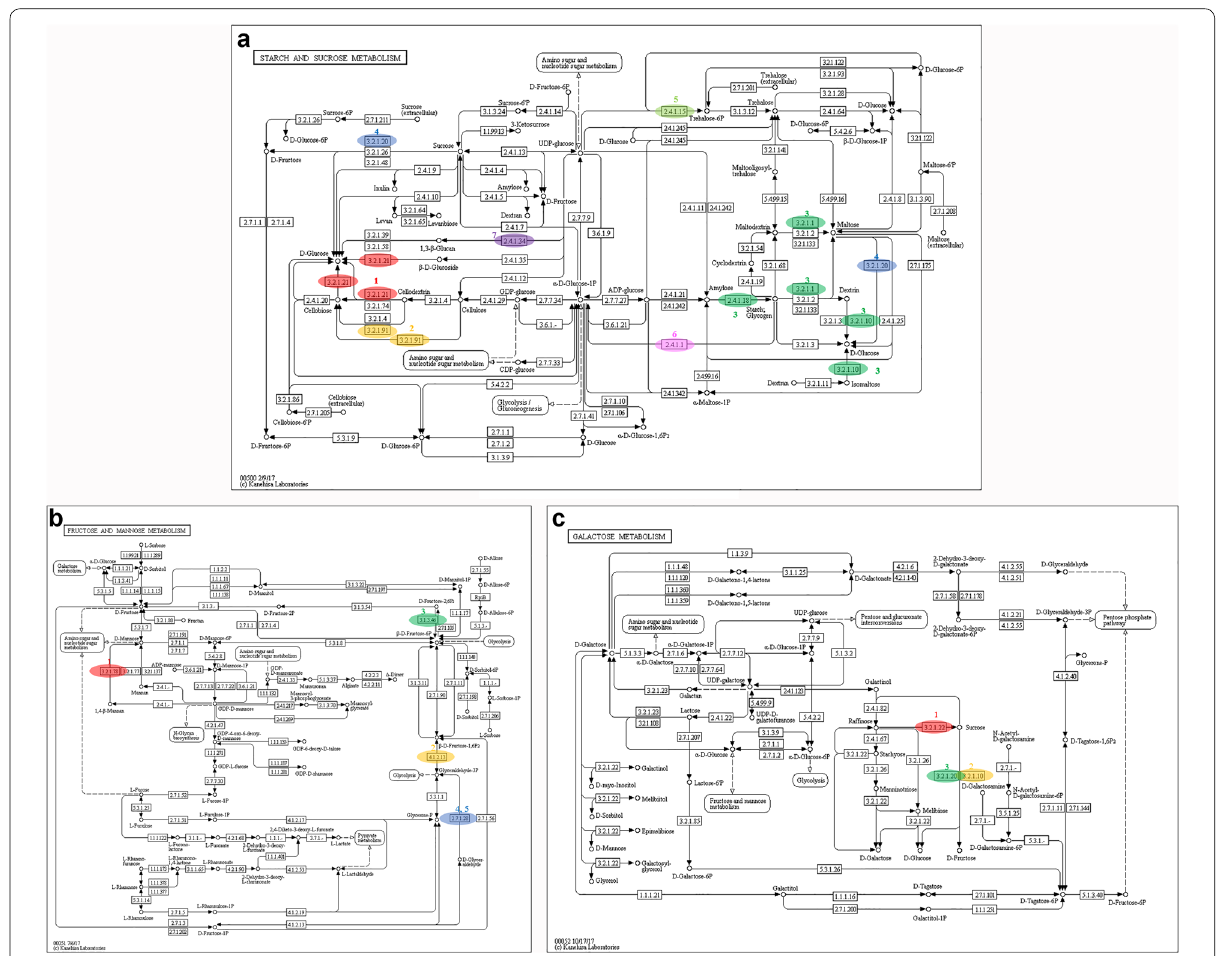
Fig. 5 KEGG mapping of the polysaccharide metabolism pathway identified in H. erinaceus . a KEGG map 00500, b KEGG map 00051, and c KEGG map 00052. The colorized oval in the map indicates the related genes from our data in this pathway. The number beside the oval is in accordance with the gene number in Table 5. Each color indicates different genes. The same color indicates the same